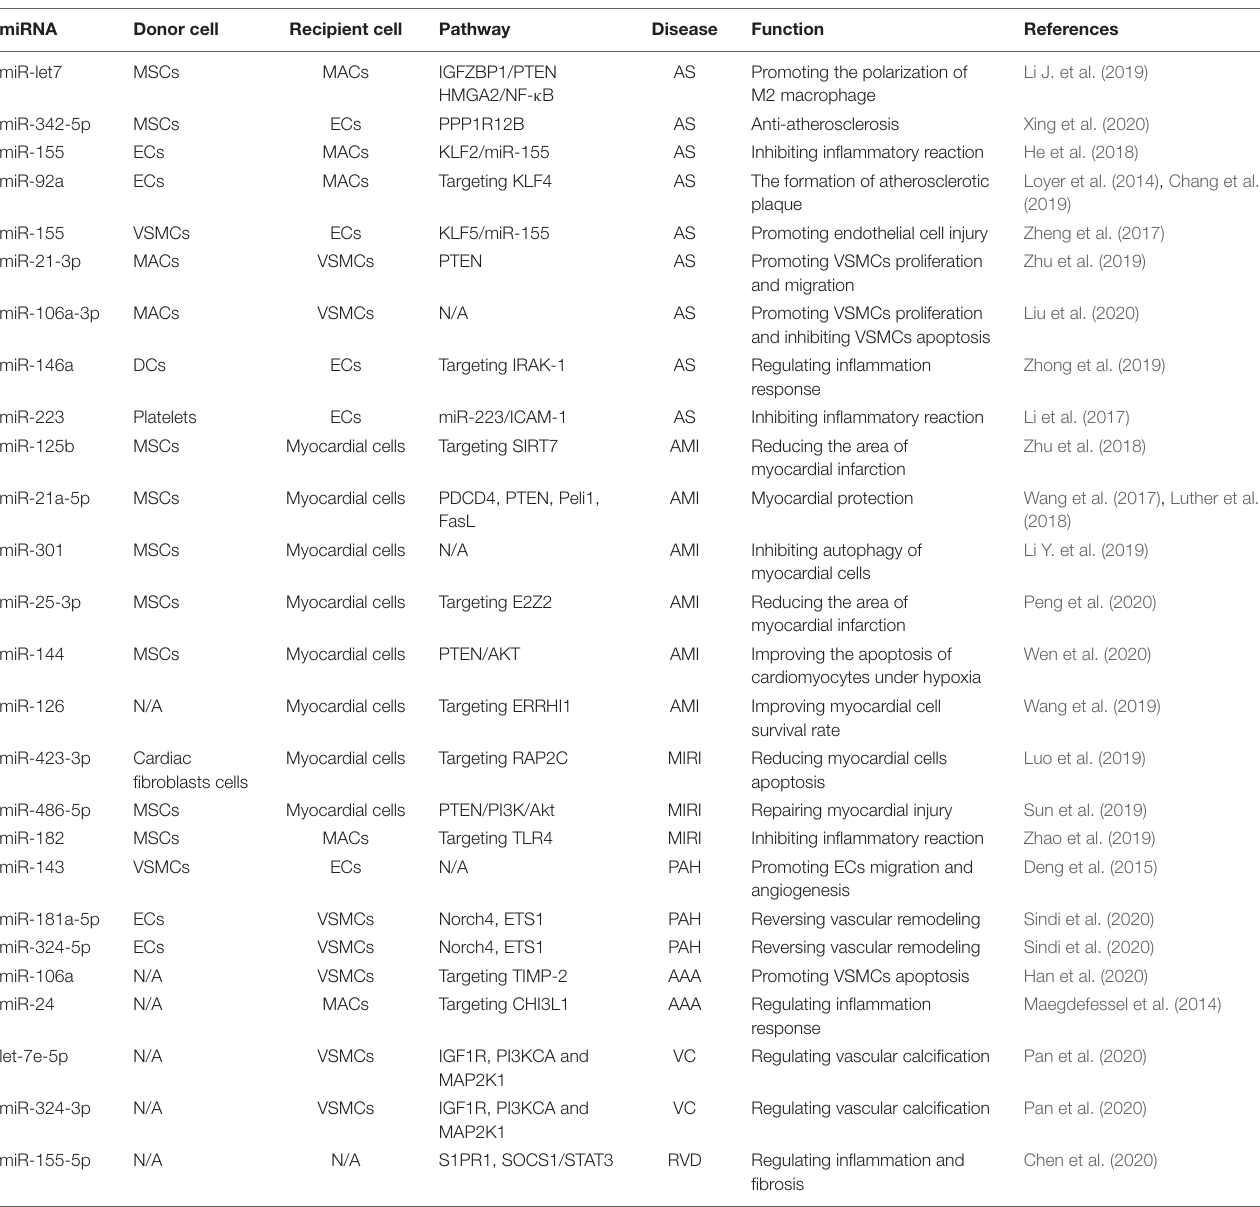
TABLE 1 | The role of exosomal miRNA in cardiovascular disease. miRNA